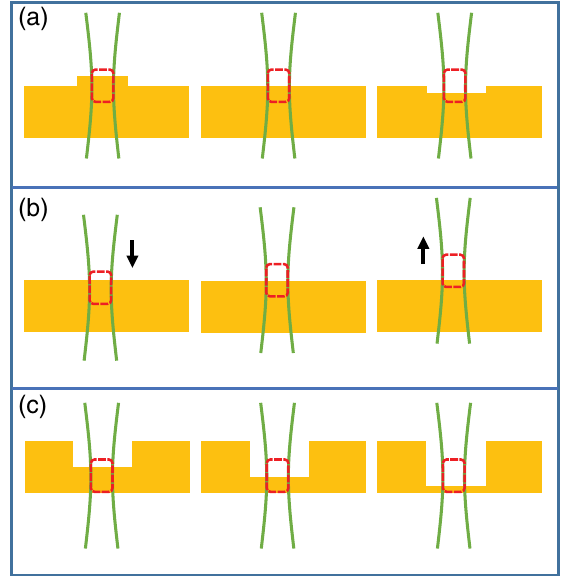
FIG. 9. (a) Experiment: constant focal plane, surface profile is changing. (b) Calibration: focal plane is changing (acquiring a z stack), surface profile is unchanged. (c) Experiment with the focal plane located deep inside the liquid film. The setting is equivalent to (a). In principle, the measured fluorescence intensity in each column should be the same. For the sake of simplicity, the calibration data are approximated by a straight line, as indicated in Fig. 10.